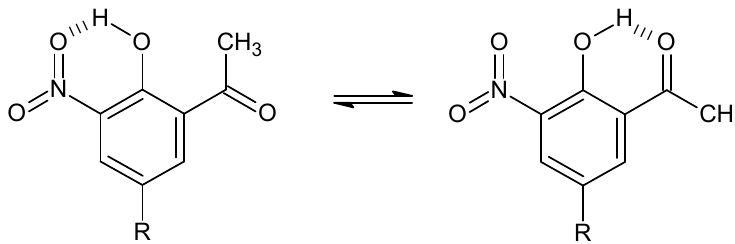
Figure 11. The scheme of the conformational equilibrium of 5-R-3-nitro-2-hydroxy-acetophenone, where R = Cl or CH 3 .